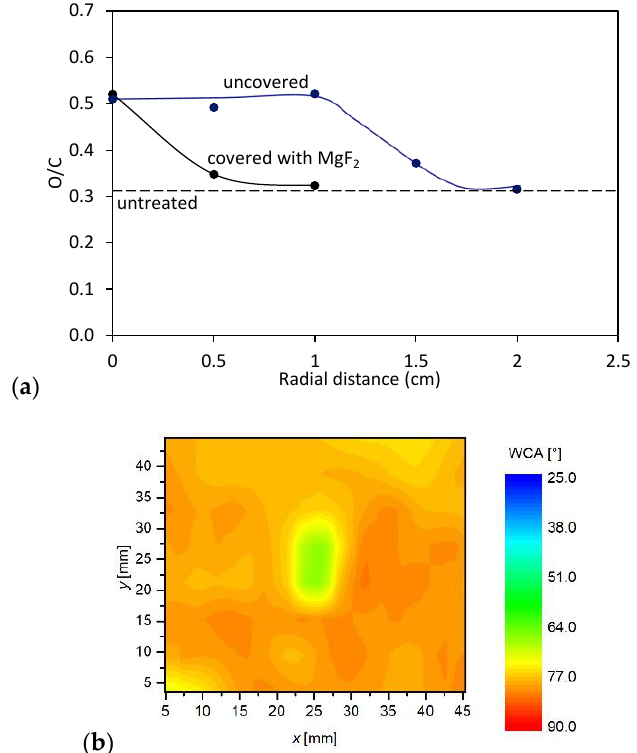
Figure 8. ( a ) Comparison of XPS ratio O/C for the sample covered with MgF 2 optical window, and thus, exposed to radiation only with the uncovered sample exposed to all reactive species. The sample was placed 5 mm from the nozzle. Treatment time was 1 min. ( b ) Mapping of the surface wettability of the polymer surface covered with a MgF 2 window. The surface wettability of the corresponding uncovered sample is shown in Figure 7 (1 min).